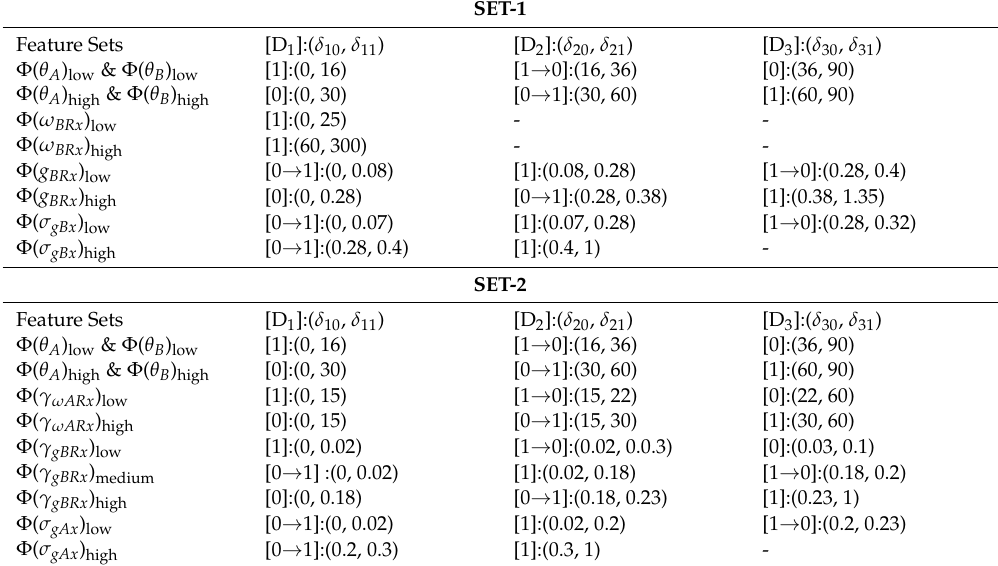
Table 1. Suggested parameter range of the trapezoidal membership functions of input features for the proposed two fuzzy sets.